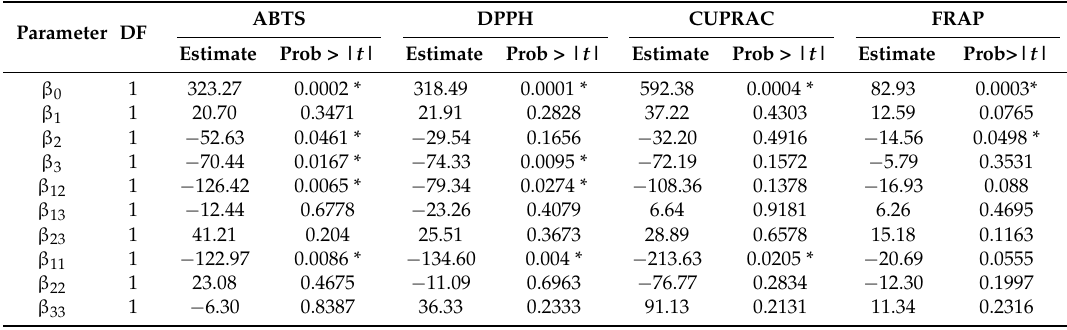
Table 4. Analysis of variance for the experimental results on antioxidant capacity.